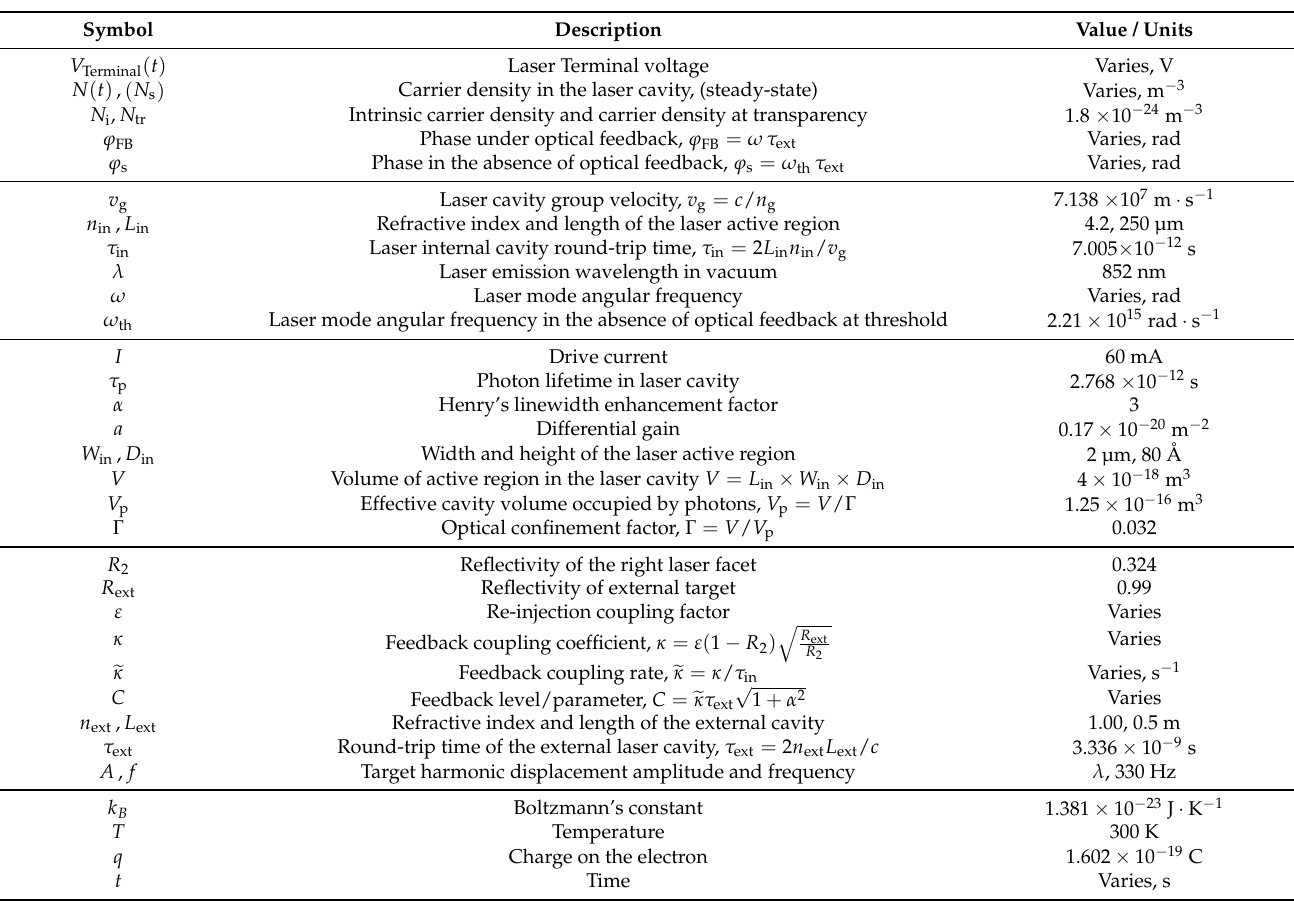
Table A1. Model parameters and values used in Equations